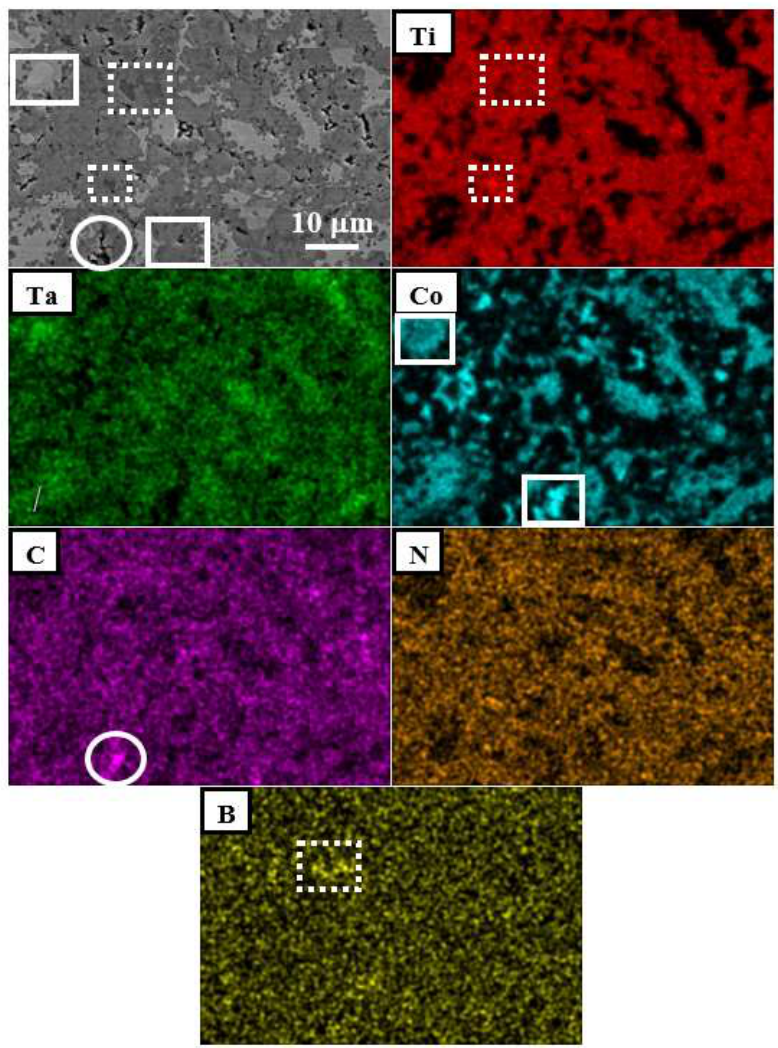
Figure 5. Energy-dispersive X-ray spectroscopy (EDS) mapping of the s2B2 sintered cermet. Continuous line squares: The three binder phases detected, i.e., (Ti,Ta)Co 2 , (Ti,Ta)Co 3 , and α -Co. Dotted line squares: Boride phases, i.e., (Ti,Ta)B 2 and / or (Ti,Ta) 3 B 4 . Circles: Artefacts caused by the porosity.